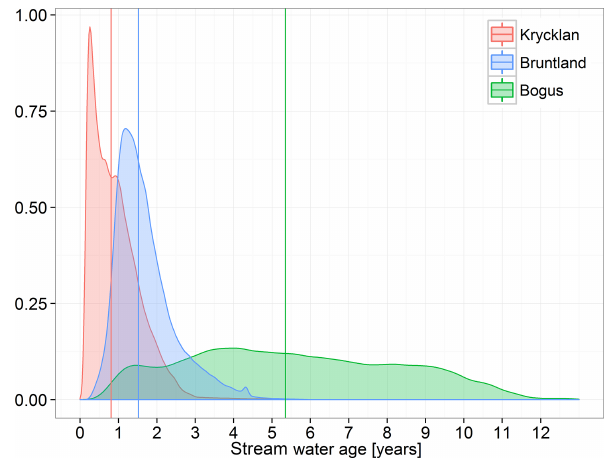
Figure 8. Probability density functions of the simulated water ages for the best 100 runs for all three catchments. The vertical lines mark the median age in each